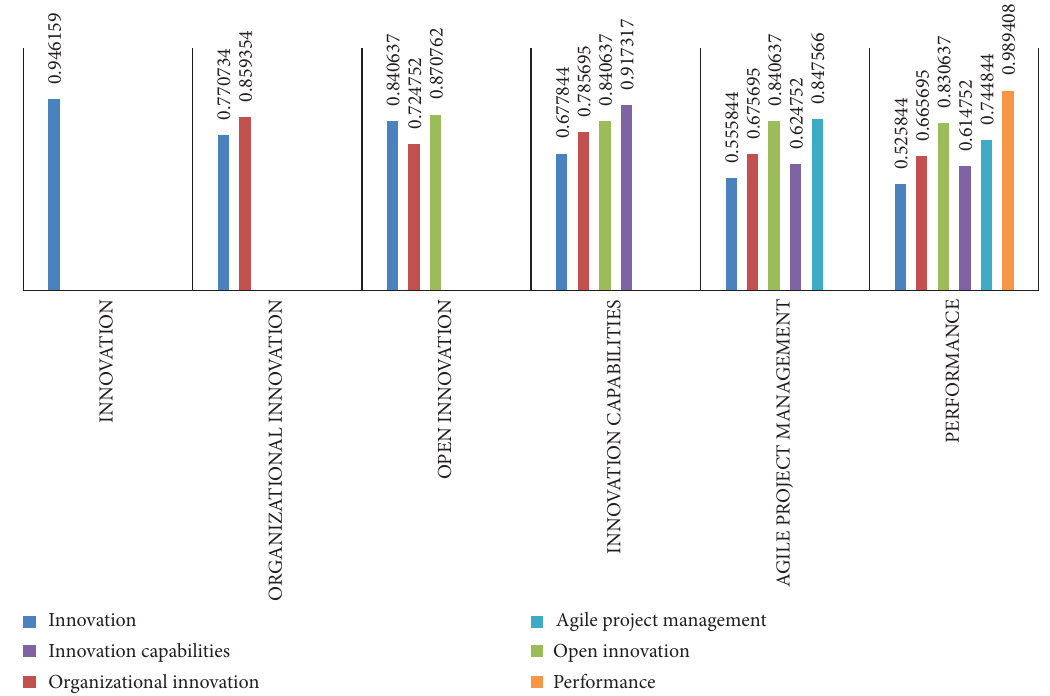
Figure 6: Divergent reliability of the model (made by researchers).